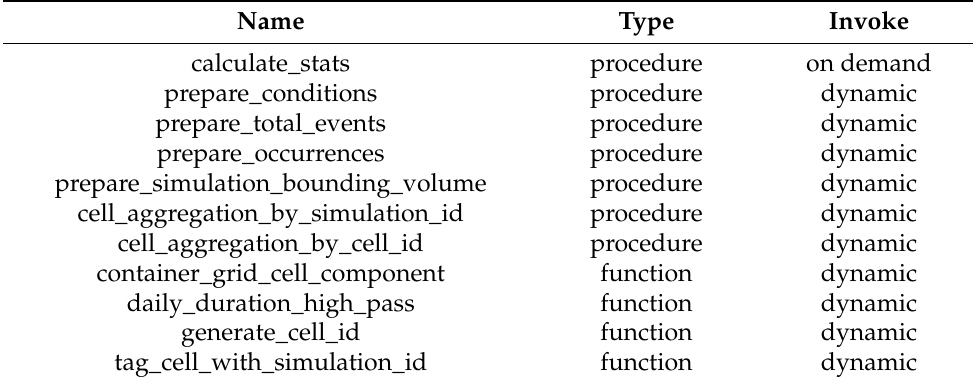
Table 3. Database functions and